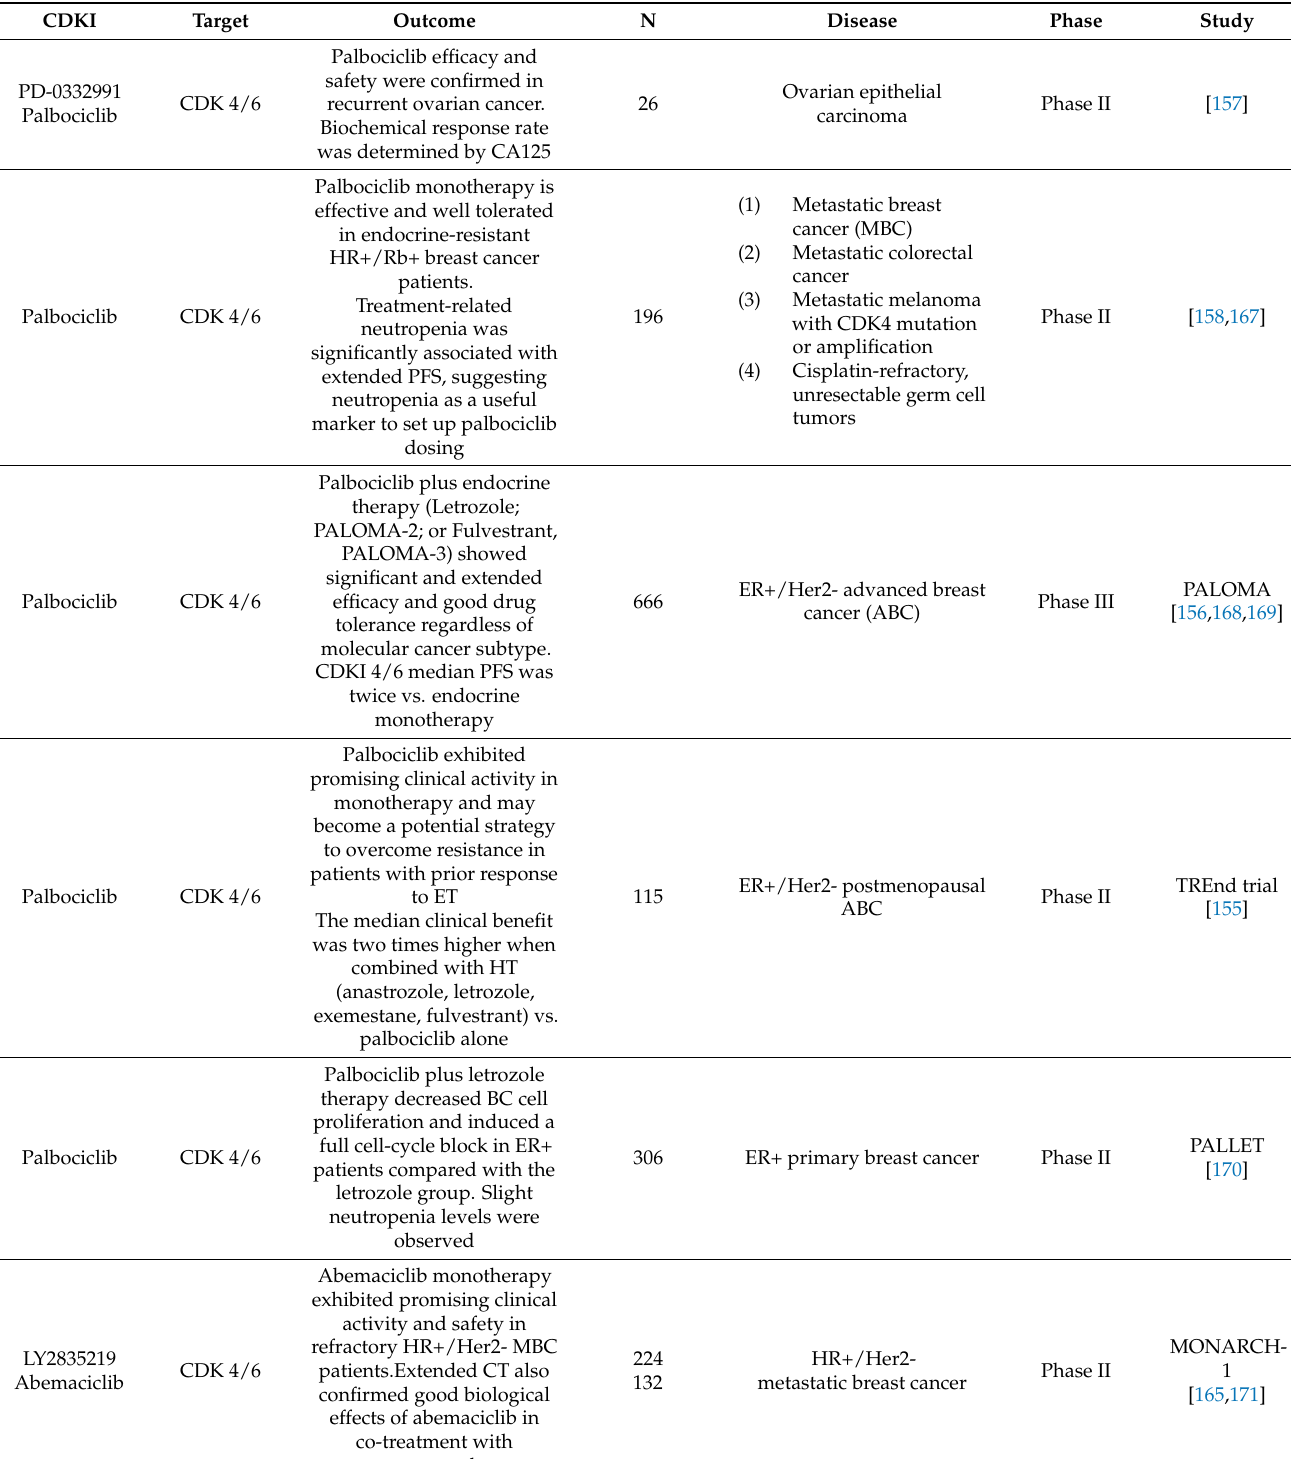
Table 3. Selected randomized and ongoing clinical trials evaluating CDKIs therapy in advanced breast and ovarian